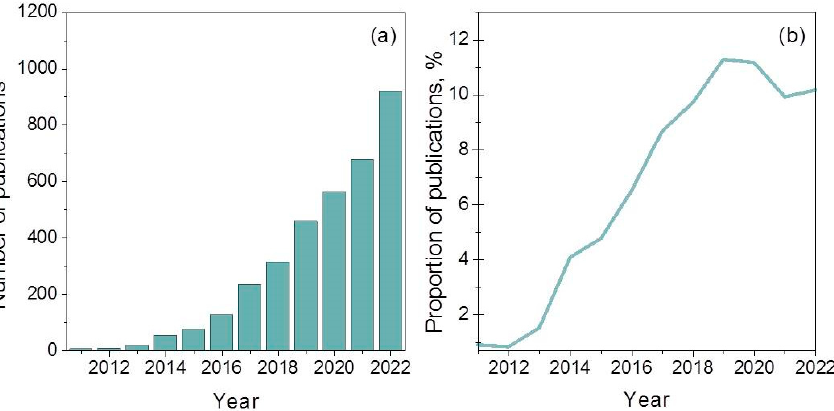
Figure 1. ( a ) Number of annual publications using “g-C 3 N 4 photocatalytic H 2 production” as a keyword since 2011. ( b ) Proportion between the number of publications with keywords “g-C 3 N 4 photocatalytic H 2 production” and “photocatalytic H 2 production” based on data of Science Direct (Elsevier).